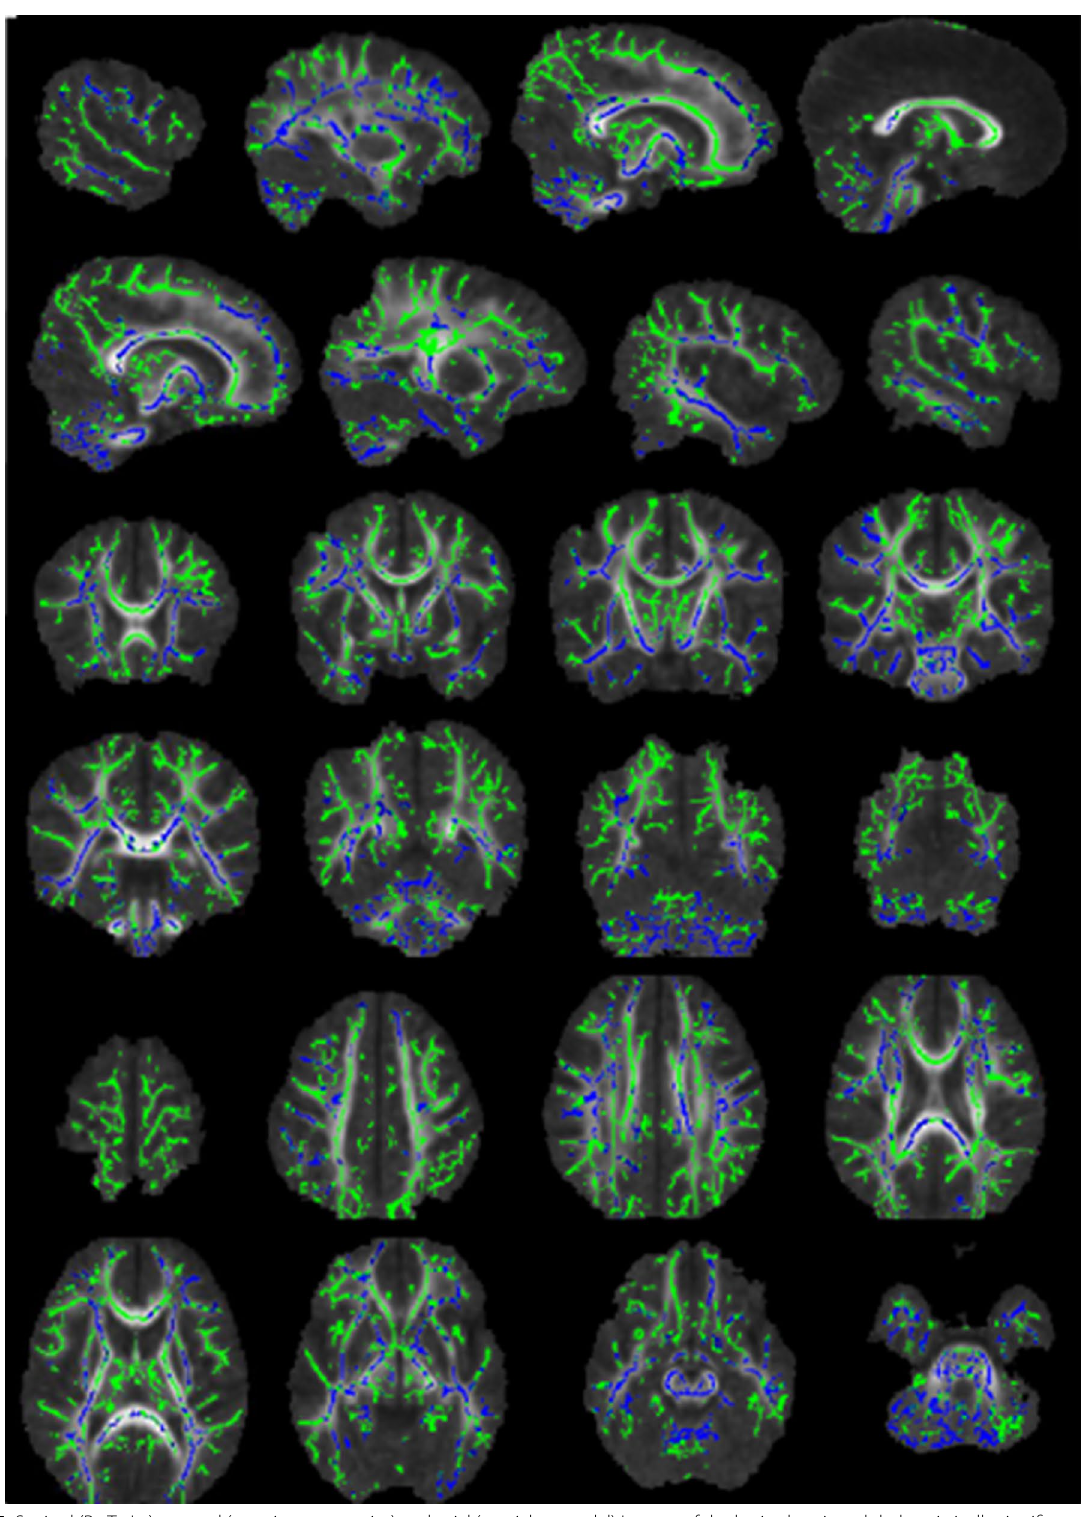
Fig. 7 Sagittal (Rt. To Lt.), coronal (anterior to posterior) and axial (cranial to caudal) Images of the brain showing global statistically significant higher mean FA values among ASD group in comparison to TDC group (blue color), while no statistically significant higher mean FA values were detected in the TDC group (supposed to appear in red